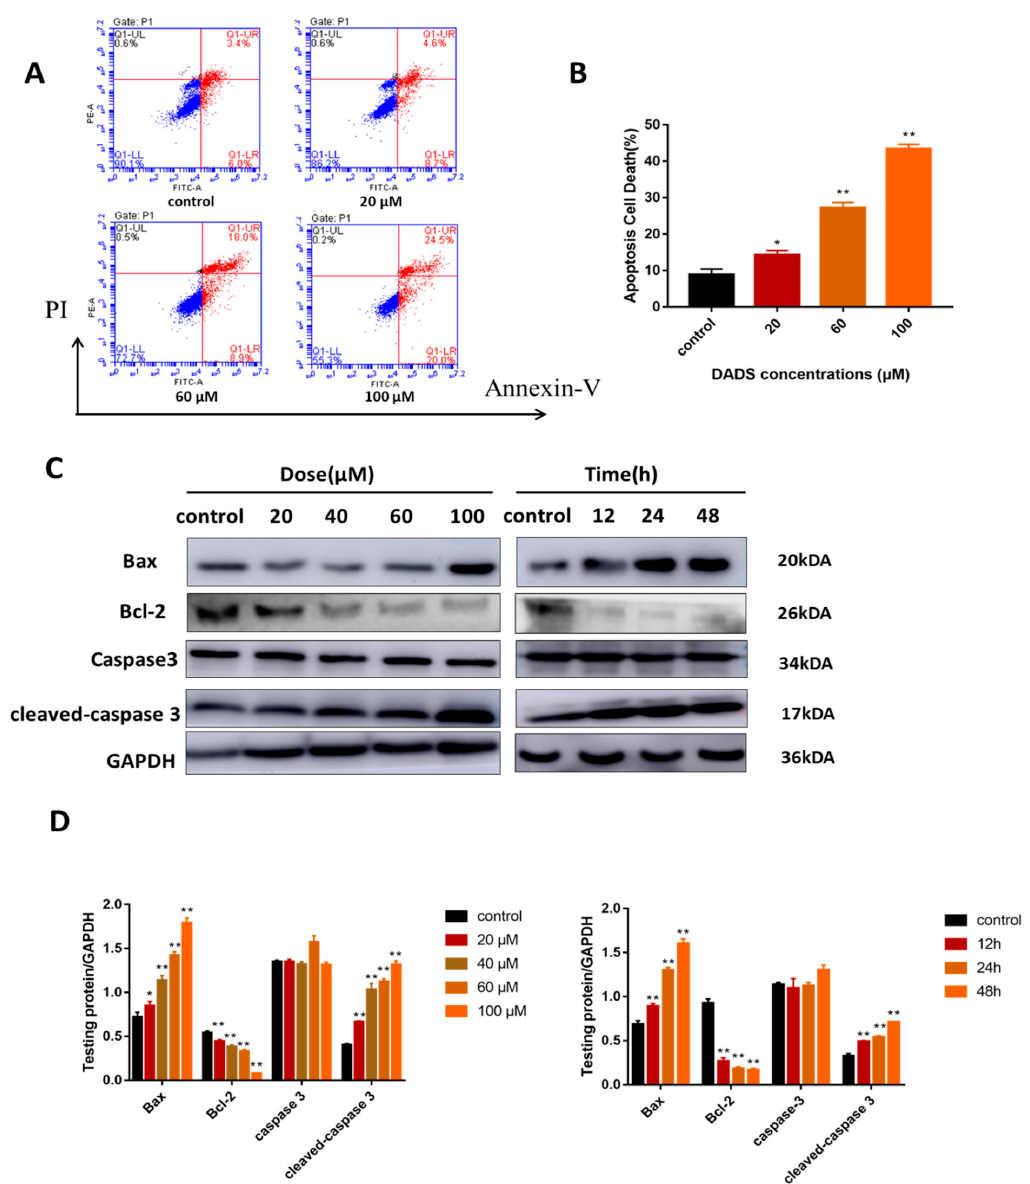
Figure 2. Induces caspase-dependent apoptosis in MG-63 cells. ( A , B ) After cells were stained by Annexin V-FITC / PI and left in dark at room temperature for 15 min, the apoptosis rate was measured by flow cytometry. Data were presented as means ± SD ( n = 3 ). ( C , D ) Cells were treated with di ff erent doses of DADs for 24 h or incubated with DADs (60 µ M) for various hours. The apoptosis-related proteins caspase-3, cleaved-caspase 3, Bax, and Bcl-2 were measured by Western blot. GAPDH was used as a loading control. ( * p < 0.05, ** p < 0.01 compared with control